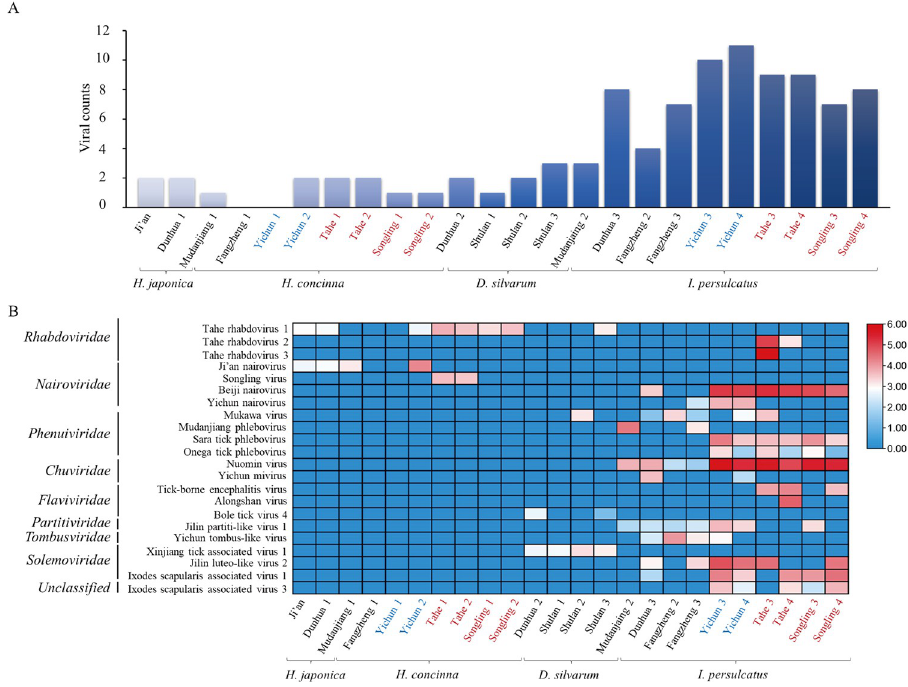
Fig 2. Viral presence and abundance across the libraries. (A) Viral number identified in each library. (B) Heatmap based on the normalized numbers of sequence reads for 8 viral families and one unclassified RNA virus in each library. Tick species and location information were listed at the bottom, and names of the viral families and species were indicated on the left. Log 10 relative abundance of the viruses in each species in each location were indicated as a heat map ranging from low (blue) to high (red) based on the normalized average viral genome size and total sequencing reads in each library. The libraries from XXAM, DXAM, and CBM are marked with blue, red, and black, respectively.